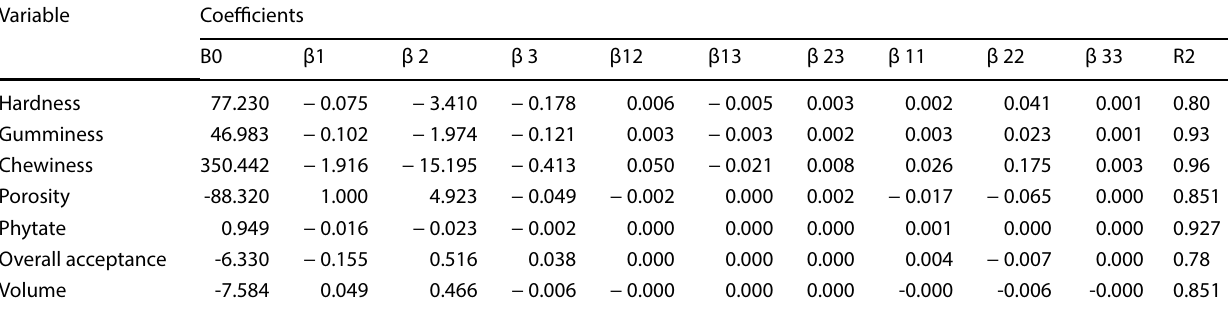
Table 2 Equation coefficients for the prediction equation of each response